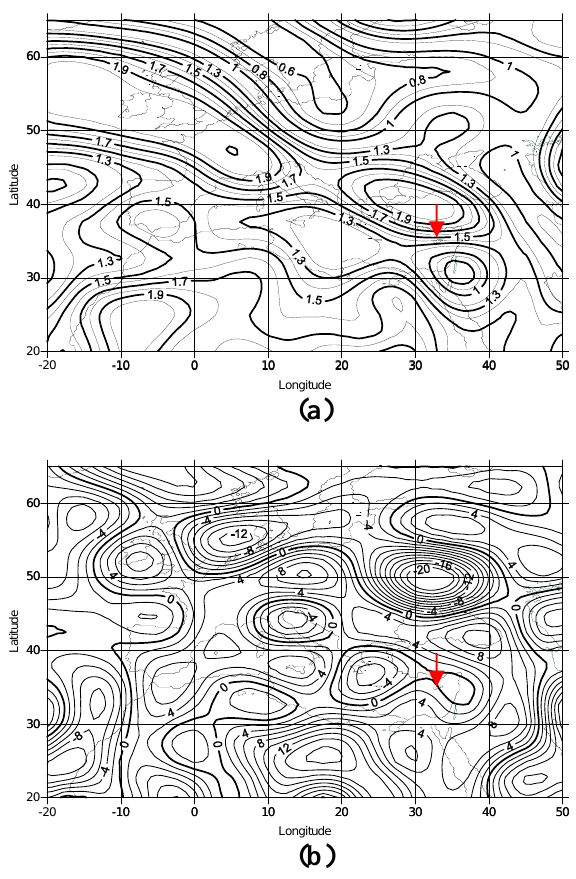
Fig. 3. (a) Static stability index (unit: K 2 s − 1 ); (b) Divergence of the horizontal wind vector (unit: × 10 − 6 s − 1 ) at the isobaric layer of 850hPa, at 00:00UTC 27 January 2008. The red arrow point to Cyprus area.